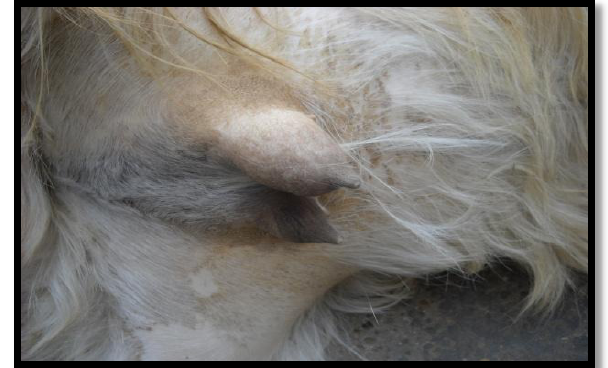
Figure, 1: The right infected half of goat showed an increase in the size when compared with non-infected left udder halves (control group after 3 days of challenge).